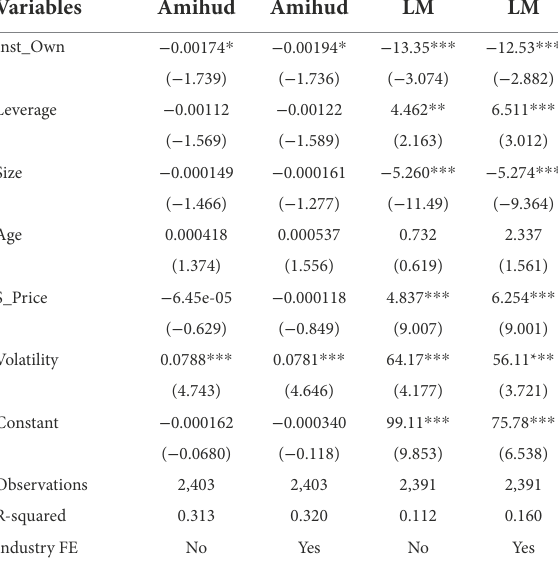
TABLE 12 Corporate governance index and stock liquidity (2SLS